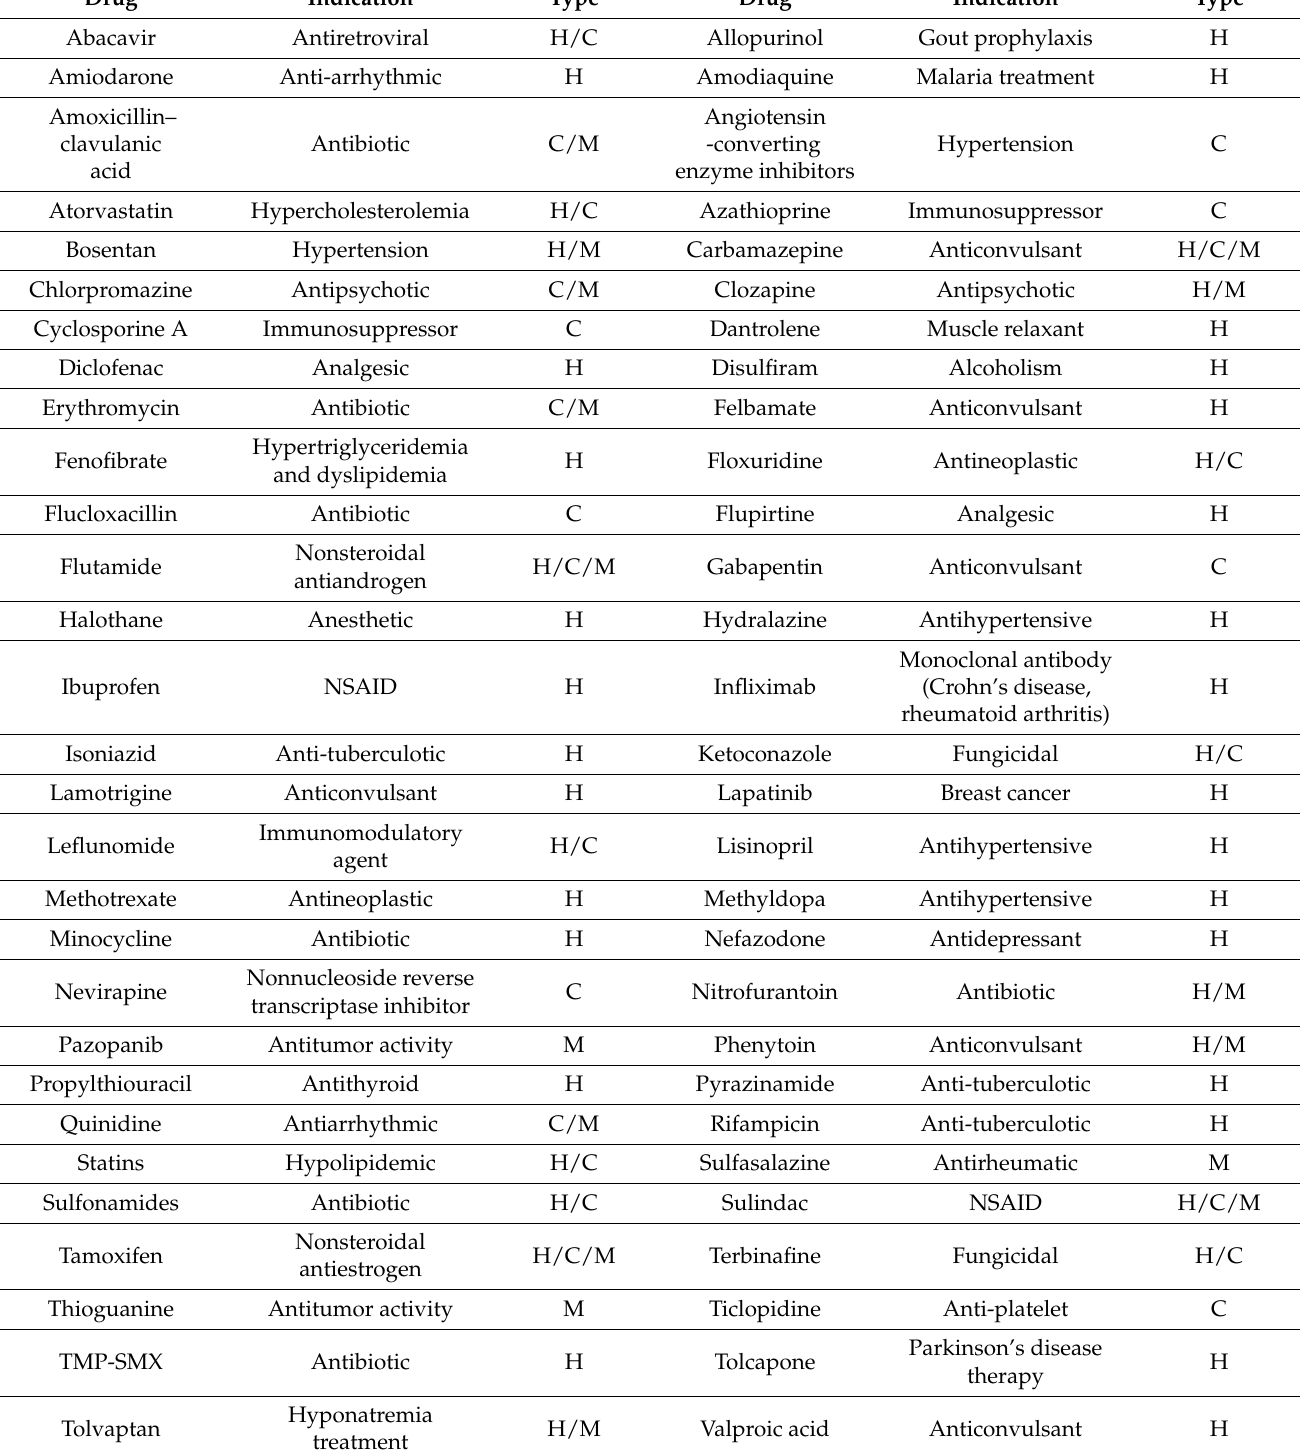
Table 1. Drugs currently associated with drug-induced liver injury